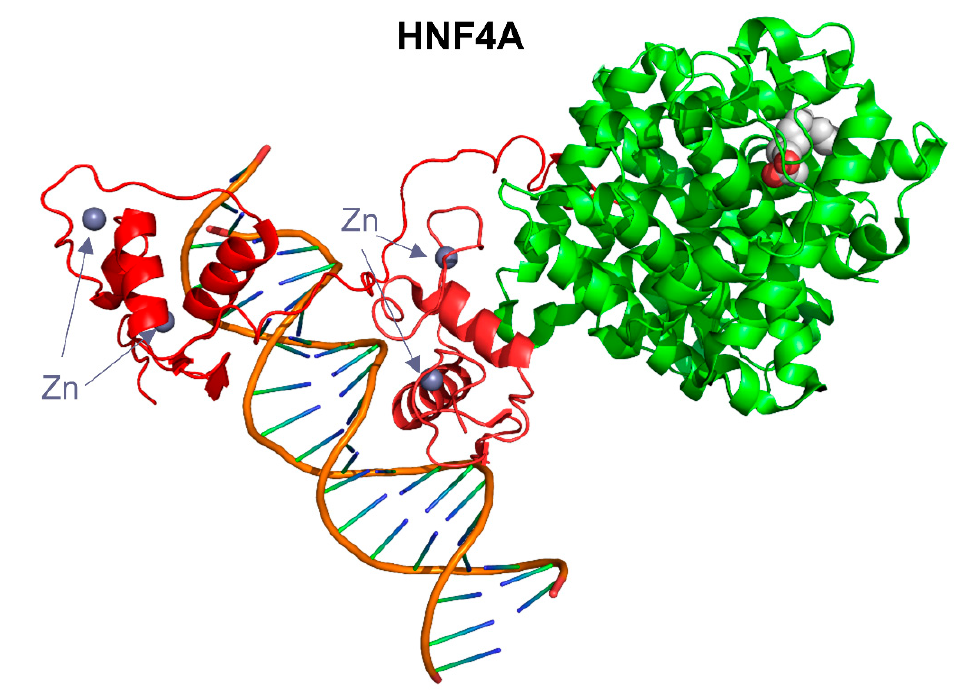
Figure 9. A visualization of the 3D model of the human HNF4A protein (PDB id 4IQR). The protein part is presented as ribbons, and the conserved DNA-binding domains are colored red.